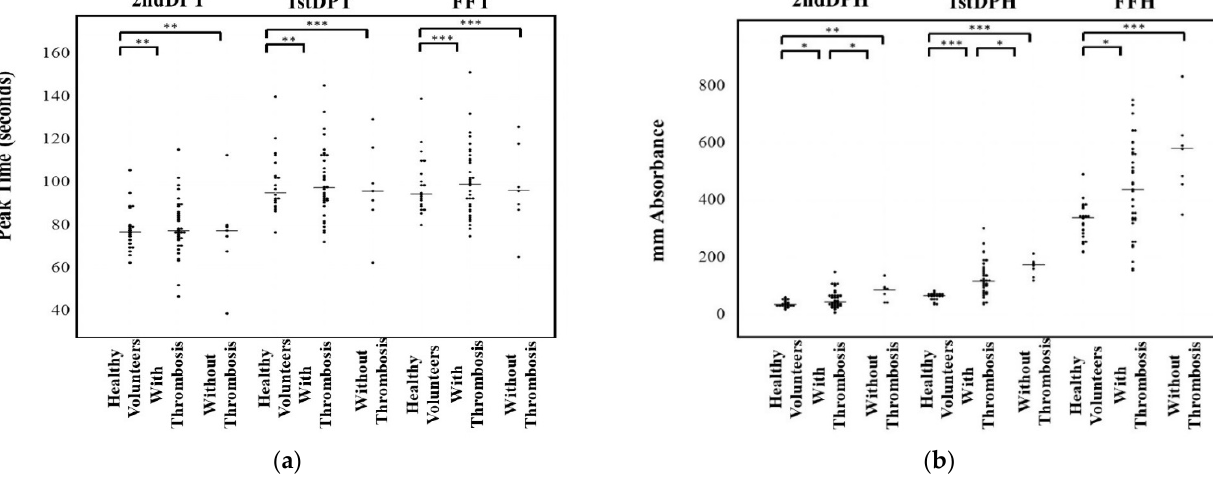
Figure 3. Peak time ( a ) and height ( b ) of small amount of tissue factor induced FIX activation assay. DPT, derivative peak time; FFT, fibrin formation time; DPH, derivative peak height; FFH, fibrin formation height; *, p < 0.05; **, p < 0.01; ***, p < 0.001.